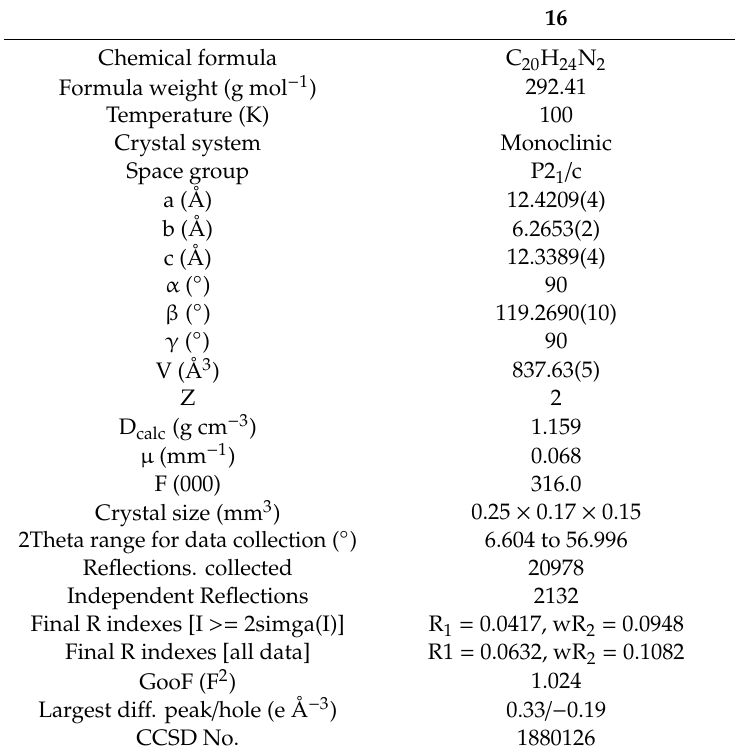
Table A2. Crystal data and structure refinement for phenazine 16